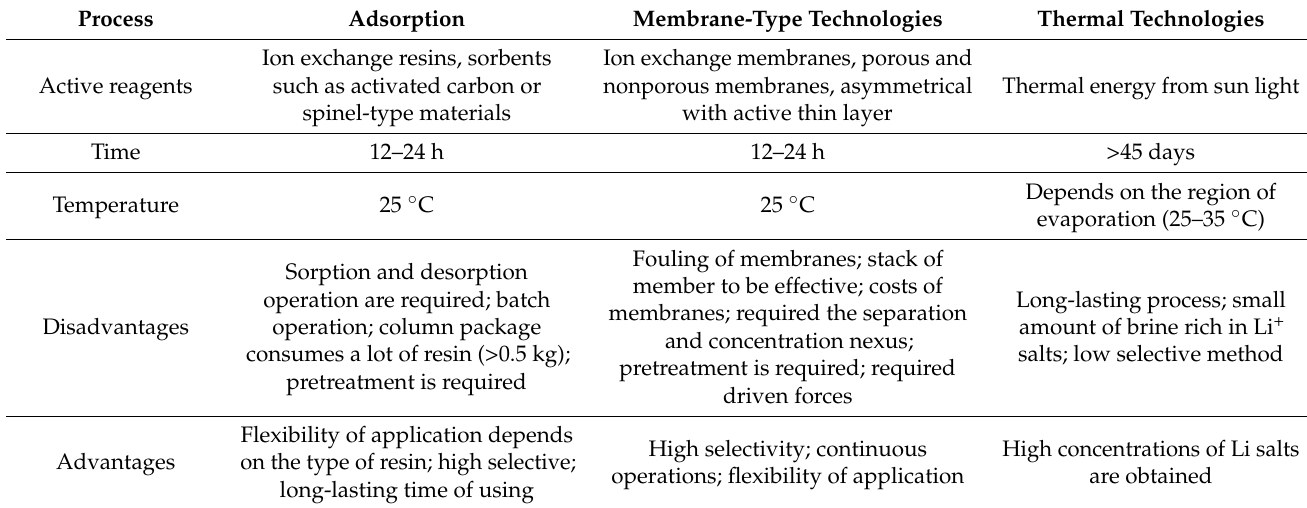
Table 5. Comparison of processes for lithium extraction from brines